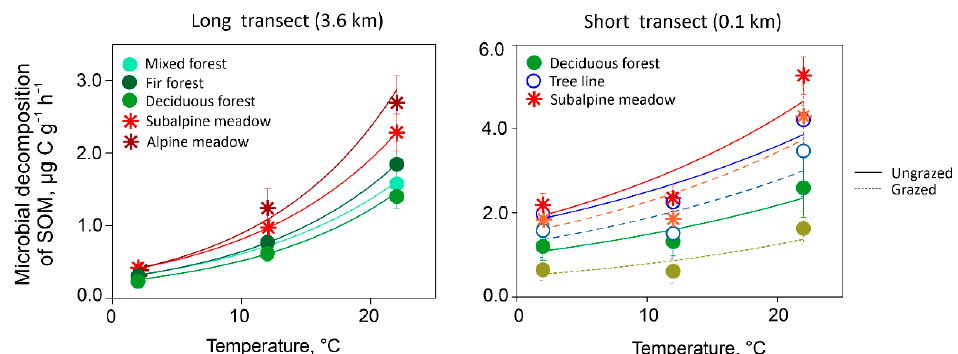
Figure 1. Microbial decomposition rate of soil organic matter (SOM) in relation to temperature for mountain forest and meadow sites along long (on the left) and short transects (on the right) with different land use. Symbols show means with standard error ( n = 3).